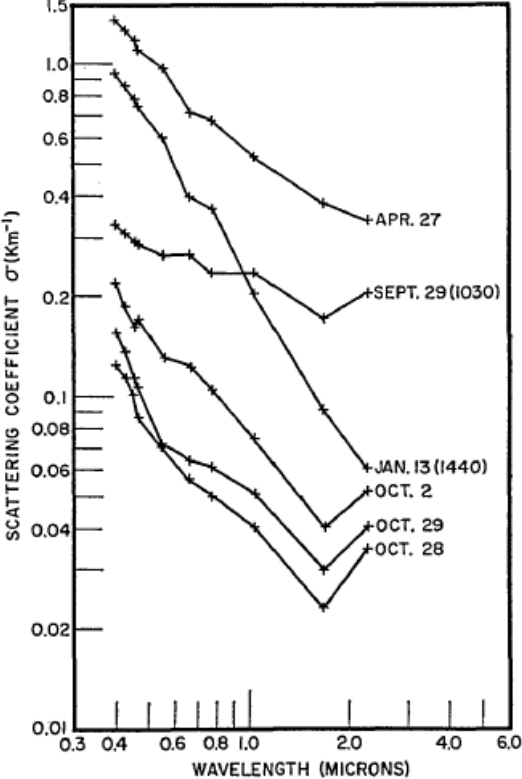
Figure 2: Atmospheric scattered light as a function of wavelength from sea level measurements over water, taken in 1959 – 1960. Corrections for water vapor and methane absorption were made. The wavelength behavior of the scattering changes on different days, presumably depending on the particulates present during the testing. These particular measurements show at best a 𝜆 − 1 . 7 change, but at other times are nearly flat. Image reproduced with permission from Knestrick et al. (1962), copyright by